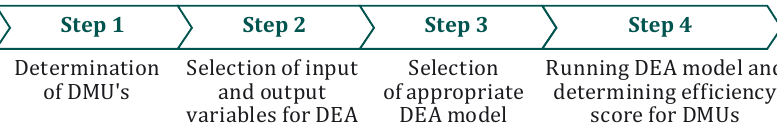
Figure 1. Research Methodology